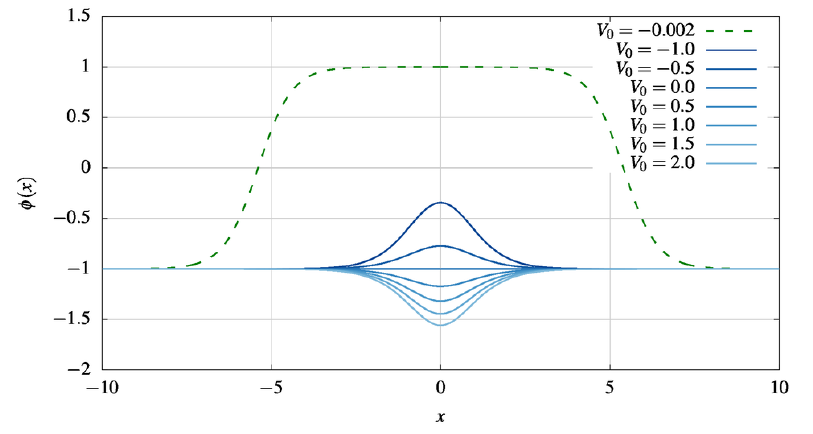
Figure 2 . Static lump solutions of the model (2.1) with the potential (2.2) at b = 1 for a few di(cid:11)erent values of V 0 .